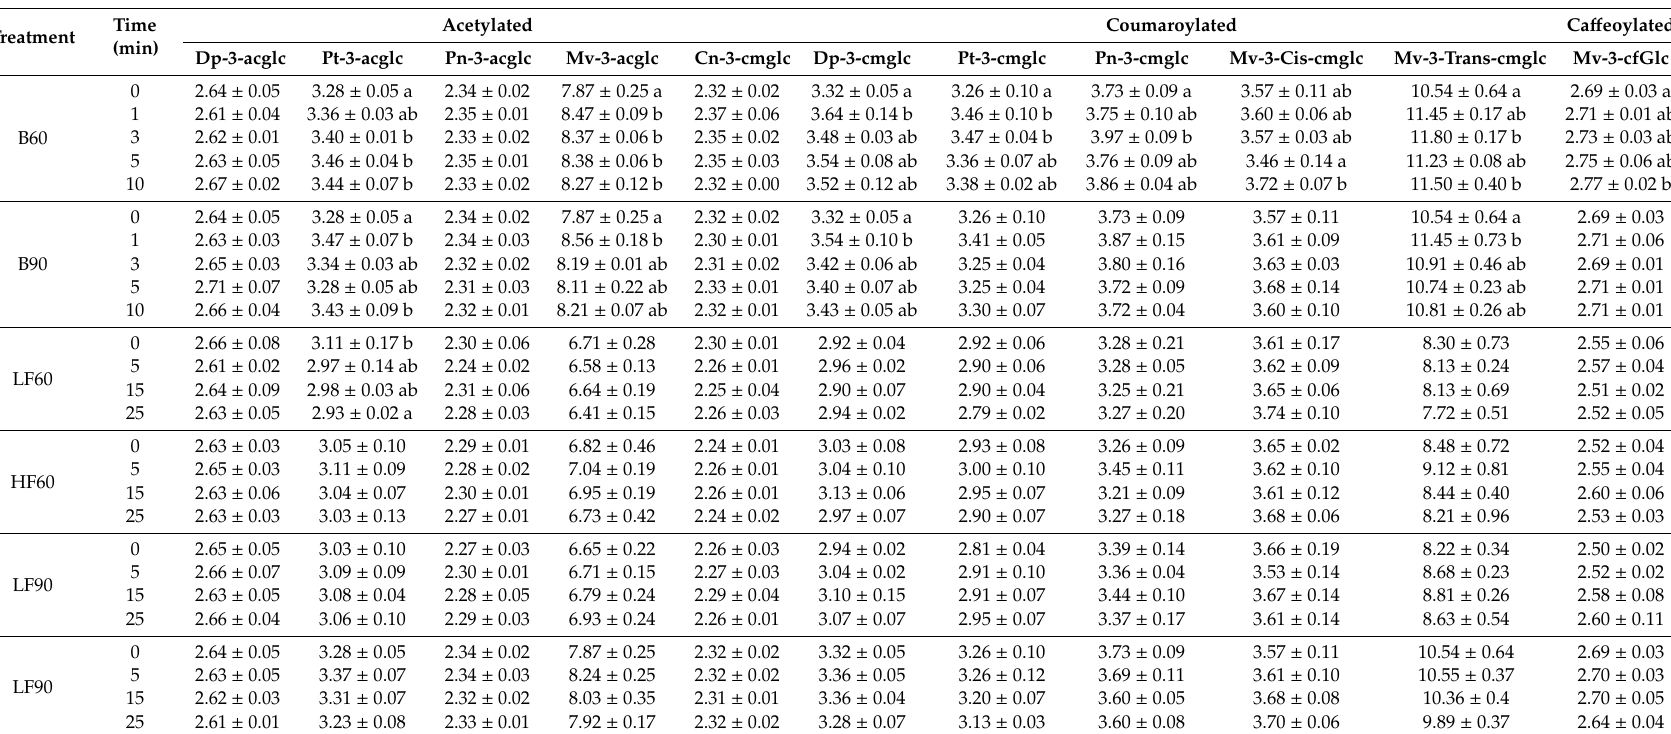
Table 5. Average acylated anthocyanin content (mg / L) (acetylated, coumarylated and ca ff eoylated) in wine with di ff erent Argon APCP treatments.